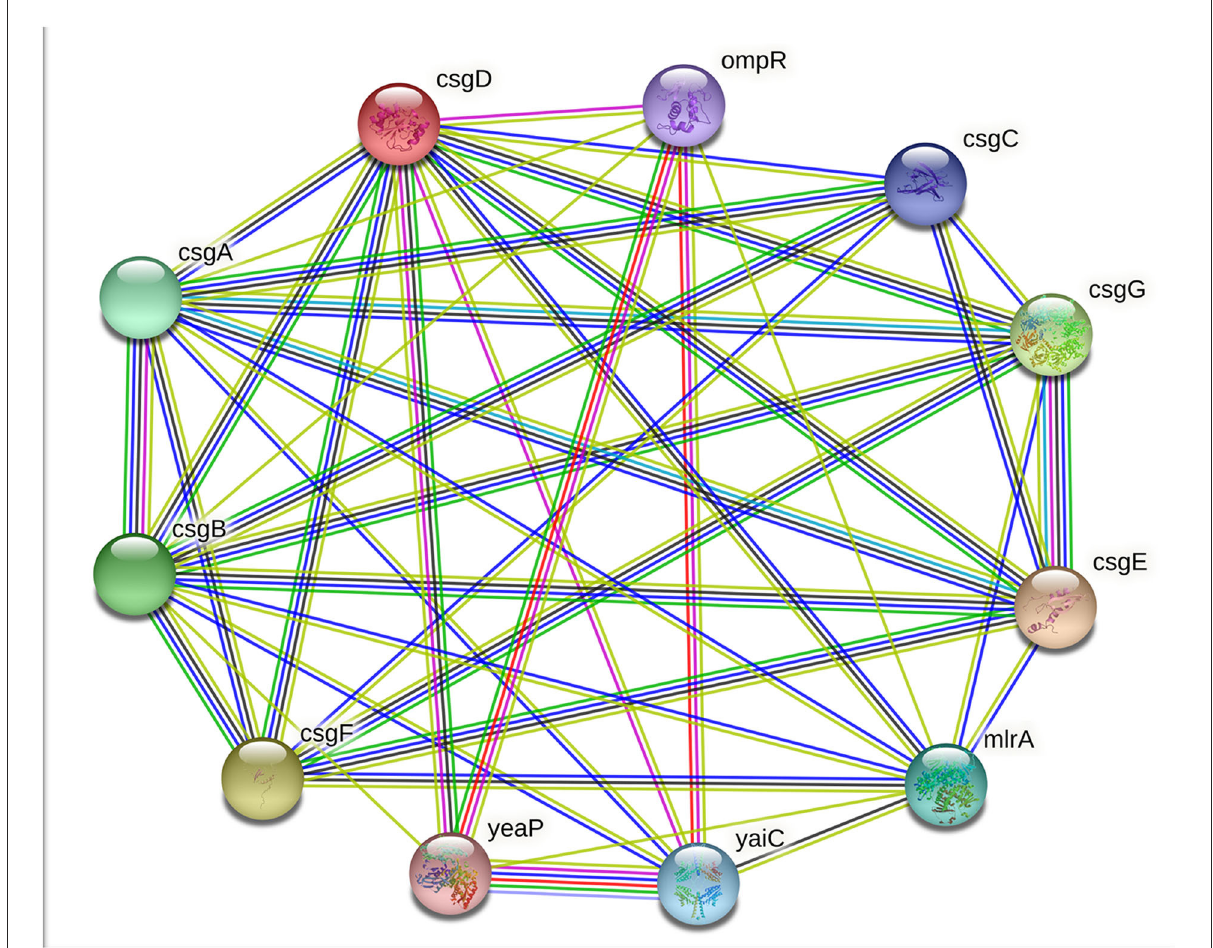
FIGURE7 String image showing CsgD and its interaction with CsgA, CsgB, OmpR, and other proteins.